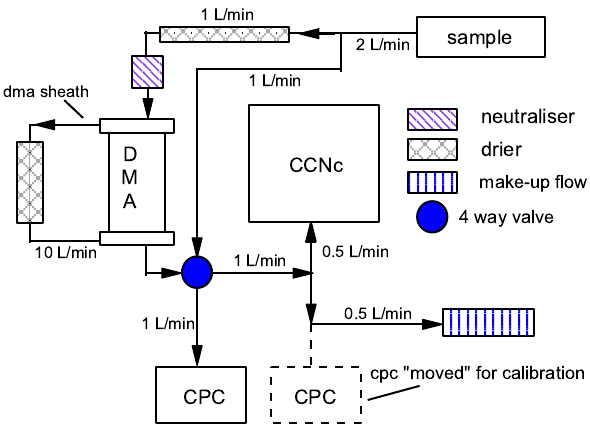
Fig. 2. CCN-DMA experimental set-up. Schematic showing how the DMA and CCNc are coupled. The 4 way-valve can be set in 2 positions, such that the CCN is either sampling aerosol from the DMA or directly from the sample and the DMA is either supplying the CCNc or the CPC. For the calibrations the CPC is connected so it samples simultaneously to the CCNc and the make-up flow is reversed to main 1Lmin − 1 sample